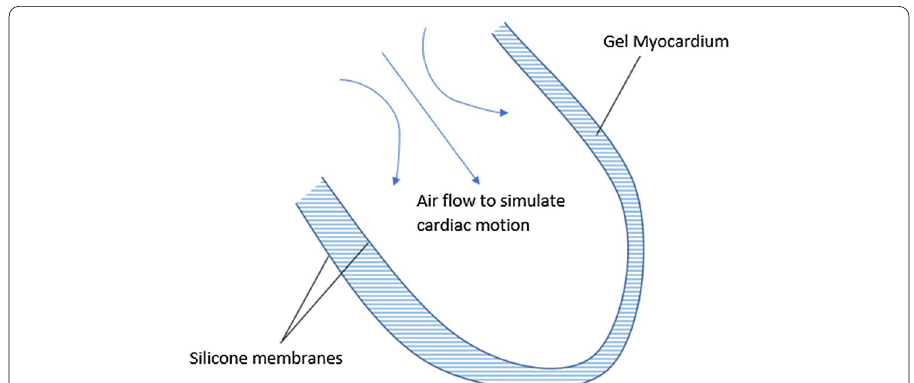
Fig. 5 A schematic demonstrating the general design concepts of phantoms to simulate cardiac motion, as used by [20, 22,